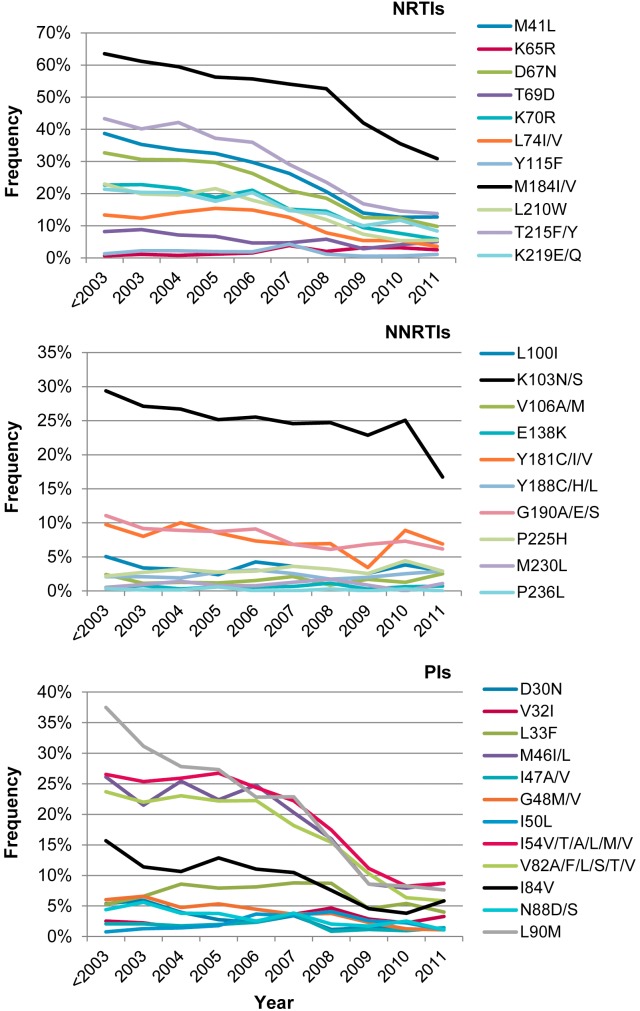
Time trends in frequency of antiretroviral resistance mutations among treatment-experienced patients.Frequency of antiretroviral resistance mutations at selected codons associated with decreased susceptibility to NRTIs, NNRTIs and PIs.